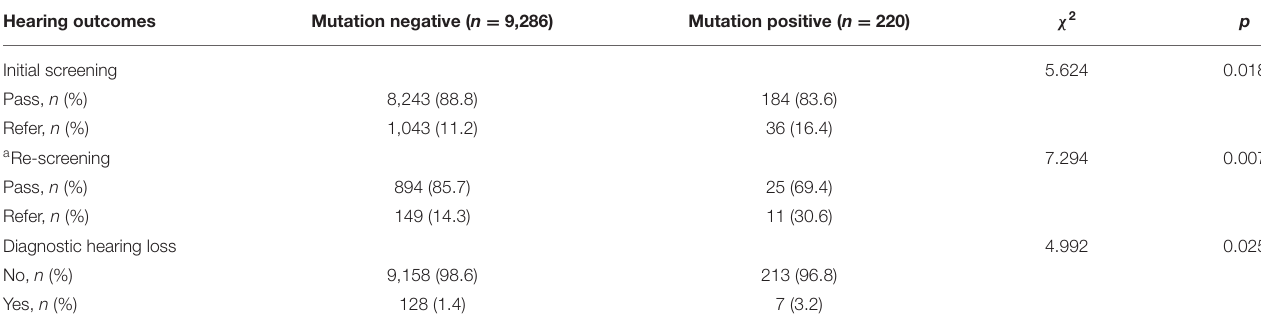
TABLE 1 | Overall results of concurrent hearing and genetic screening.